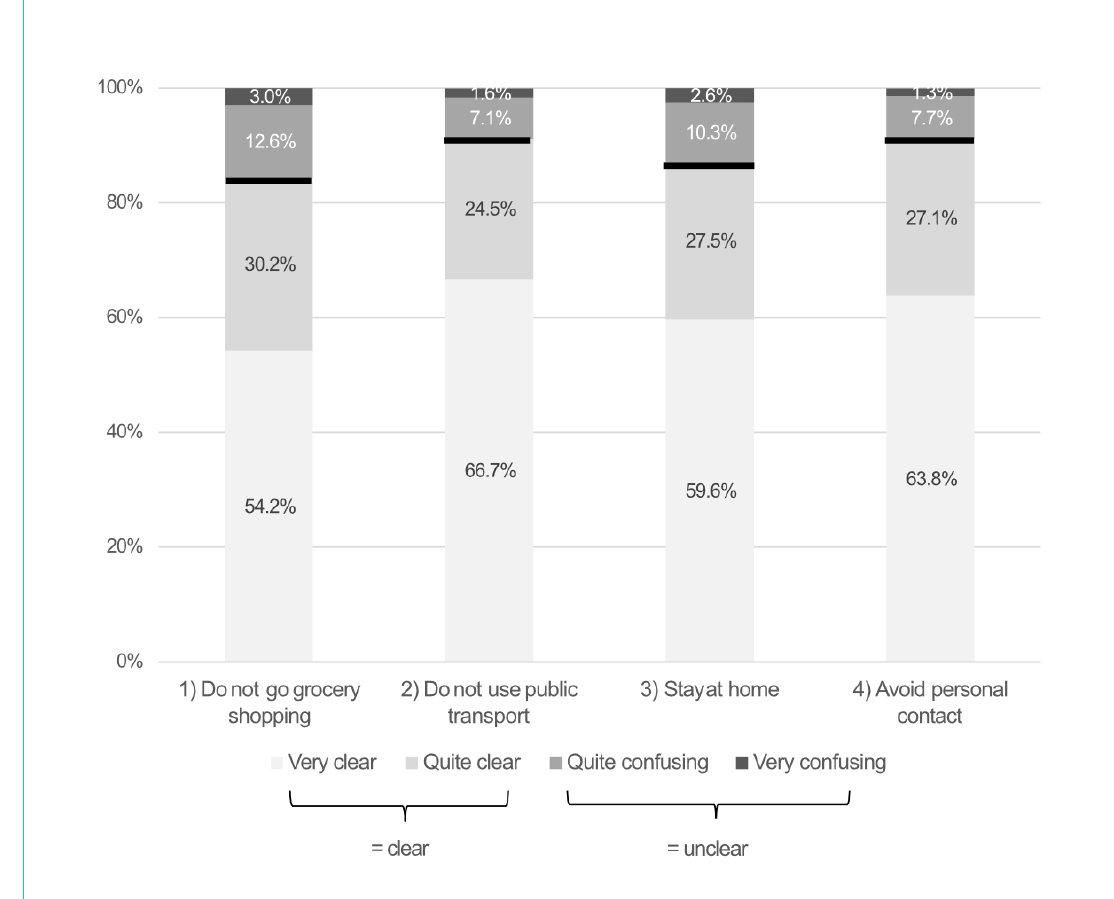
Figure 1: Clarity of the